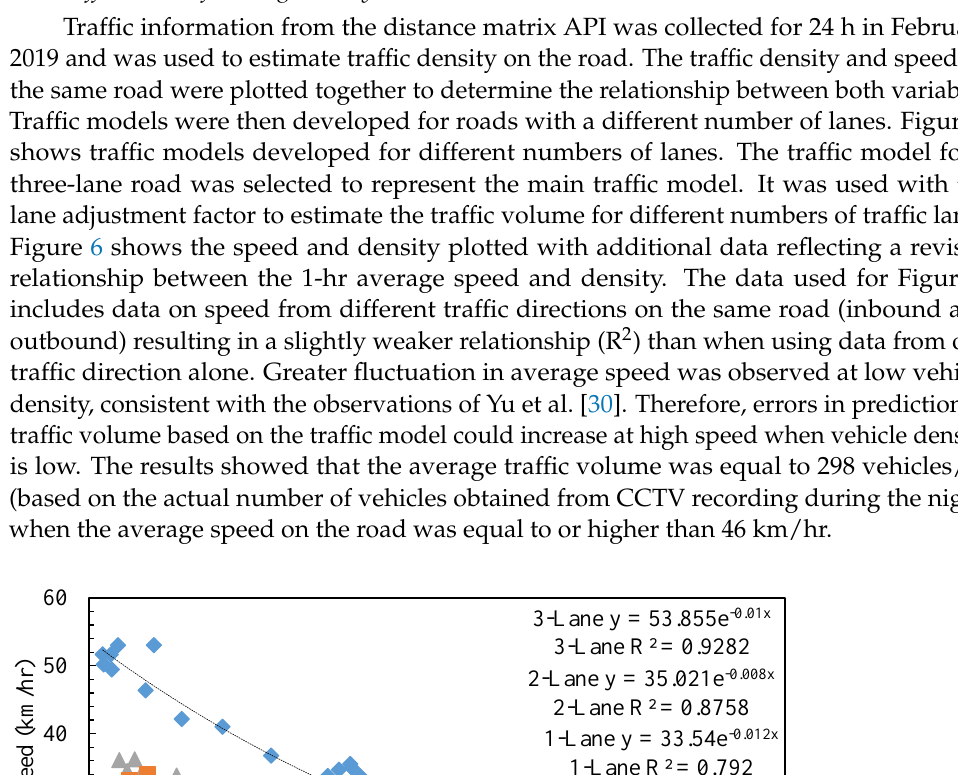
Figure 6. Traffic models of the 3-lane road with more samples . 3.3. Development of the Lane Adjustment Factor